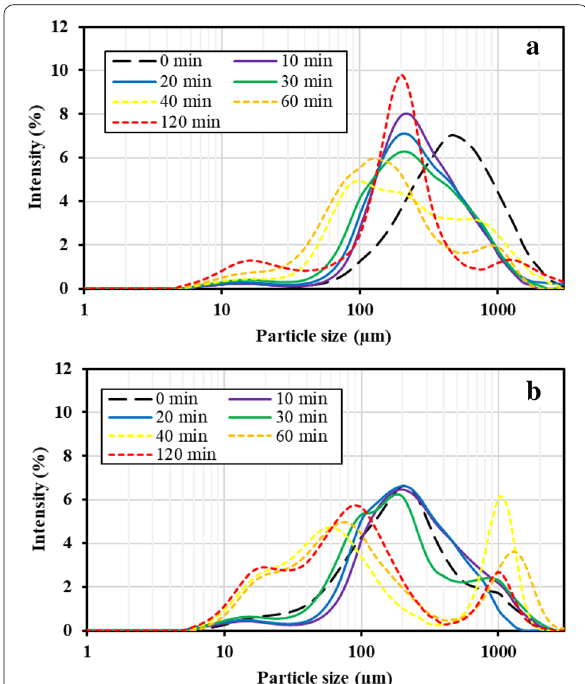
Fig. 3 The particle size distribution after the screened process for 90–180 µm obtained by a heat drying condition and b freeze-drying